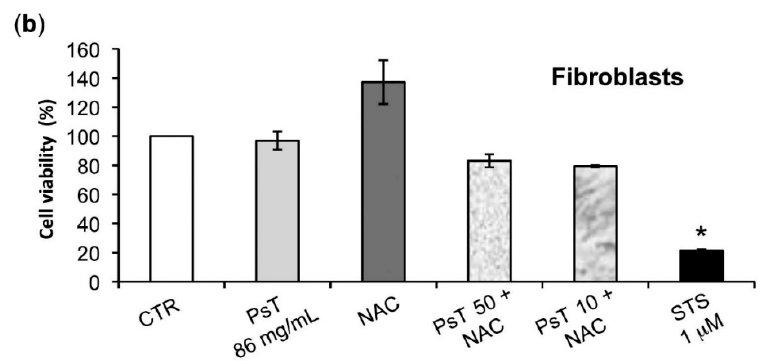
Figure 7. Effect of (PsT + NAC) ® on normal cells. ( a ) Viability of IEC-6 cells; ( b ) the viability of human gingival fibroblasts ( b ) was evaluated after treatment with NAC alone, PsT 86 mg/mL alone, (PsT 50 mg/mL + NAC) ® , and (PsT 10 mg/mL + NAC) ® and Staurosporine (STS) as a positive apoptosis control, for 24 h. The results showed that the combined treatments did not affect normal cells. Cell viability was assessed by MTT assay, performed for six independent experiments. One-way ANOVA was applied. * = significant differences compared to control cells ( p < 0.05).